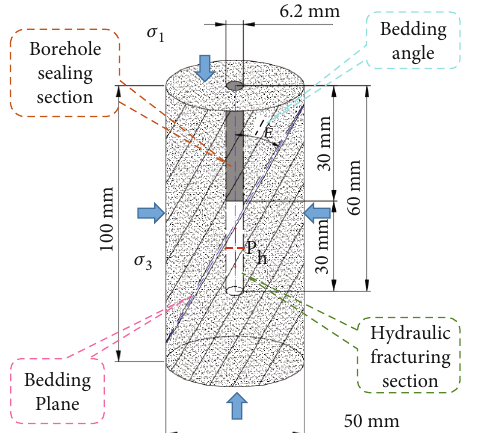
Figure 3: Schematic diagram of sandstone